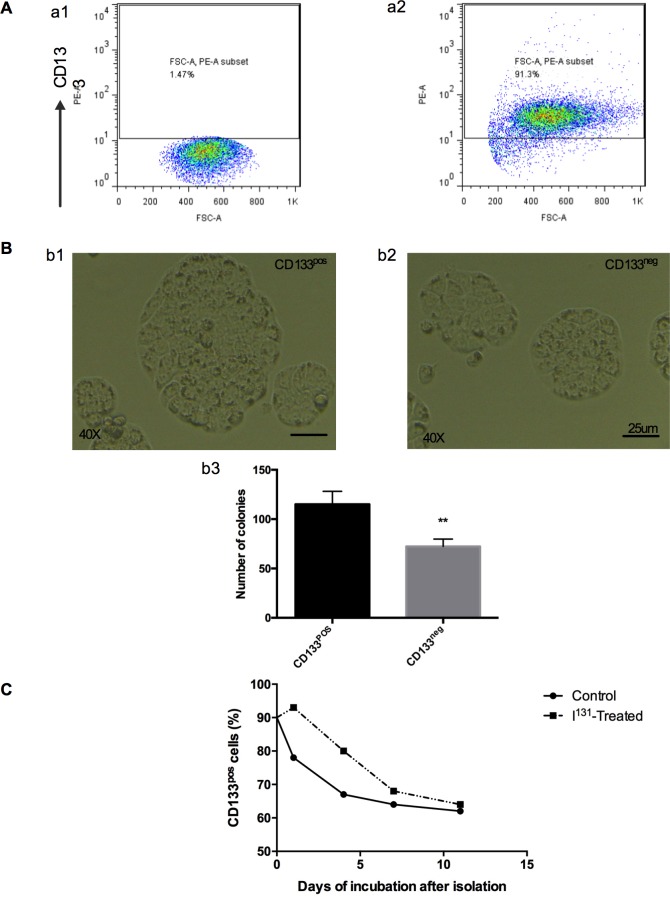
Colony formation assay of ARO CD133-positive and ARO CD133-negative cells, and differentiation of CD133-positive cells with or without 131I treatment.A-a1. The percent of CD133-positive cells in the isotype control group. A-a2. The CD133-positive cell purity after MACS was conducted. B-b3. The number of colonies after 2-week incubation. **P < 0.01. B-b1, b2. The CD133-positive and CD133-negative colonies formed after 5 days. C. The proportion of CD133-positive cells after magnetic sorting on day 0, 1, 4, 7, and 11.